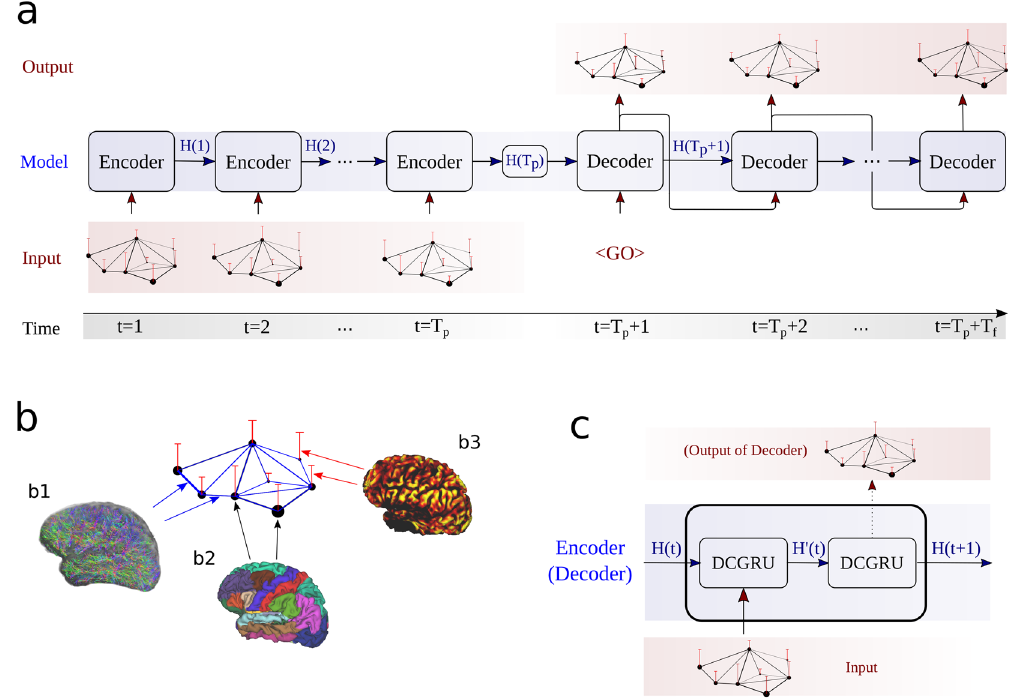
Figure 1. An overview of the DCRNN model. The model consists of an encoder and decoder ( a ), modified to process graph structured signals ( b ). In our context, vertices (nodes) V , | V | = N of the graph G are defined as N brain regions, derived from an atlas ( b2 ). Structural connections between brain regions are derived from DTI, quantifying the strength of edge connections in the graph ( b1 ). The signal on the graph x ( t ) at a certain time point t is the average BOLD signal in brain regions/nodes, obtained by the fMRI measurement at time t ( b3 ). The encoder ( a ) receives an input sequence [ x ( 1 ) , . . . , x ( T p ) ] , and iteratively updates its hidden state H ( t ). The final encoder state H ( T p ) is passed to the decoder part, which learns to recursively predict the output sequence of graph signals [ x ( T p + 1 ) , . . . , x ( T p + T f ) ] in the future. The encoder, as well as the decoder ( c ) consist of diffusion convolution gated recurrent unit cells (DCGRU). The first encoder and decoder cell receive the input graph signal, and they pass their hidden state to the subsequent cell. In the decoding part, the final cell of the decoder generates then the predicted signal ( c ). During testing and validation, the decoder uses its own outputs as inputs, to generate the subsequent output. The first input of the decoder ( < GO > symbol) is simply a vector of zeros. Figure ( b1 ) was created with the MRtrix3 software package 35 (version 3.0) : https:// www. mrtrix. org/, and figure ( b2 ) and ( b3 ) with the Connectome Workbench (version 1.4.2): https:// www. human conne ctome. org/ softw are/ conne ctome- workb